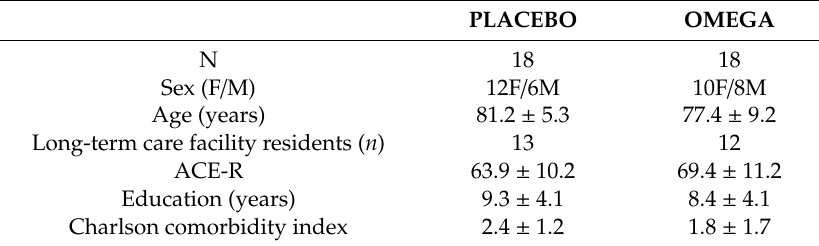
Table 1. Baseline characteristics of